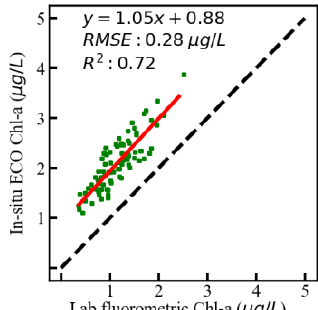
Figure 10. Regression analysis between lab fluorometric and in-situ ECO (Environmental Characterization Optics) chlorophyll-a (Chl-a) concentration.